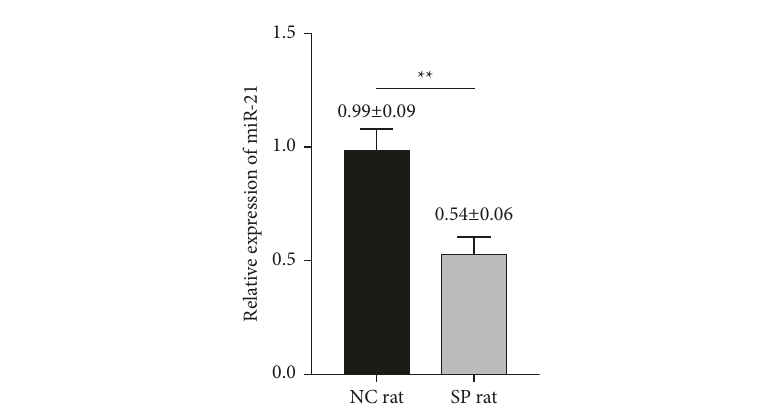
Figure 3: The relative expression of miR-21 was changed in lymphocytes of septic rats. The relative expressions of miR-21 in eight-paired NC rat group and SP rat group were determined by real-time quantitative PCR [ t value � 23.037, p < 0.01]. NC group: normal control group; SP group: sepsis group. ∗∗ p < (Treg: NC versus SP) � 9.836, p < 0.01; t value (Treg: miR-21 mimic versus SP) � 5.991, p < 0.01; t value (Treg: miR-21 inhibitor versus SP) � 5.180, p < 0.01] (Figures 5(a)–5(d)).